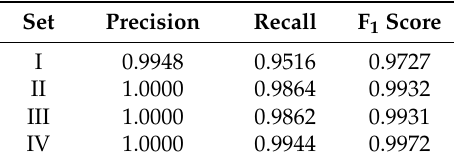
Table 7. Precision, recall and F 1 score according to